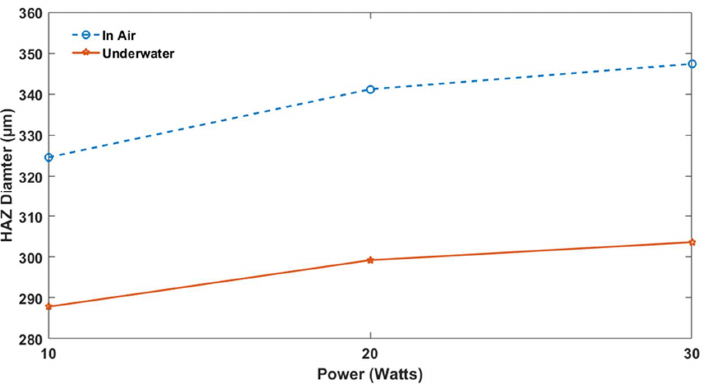
Figure 8. Variation in HAZ size with respect to laser power in the LBMM process and the LA-LBMM process.